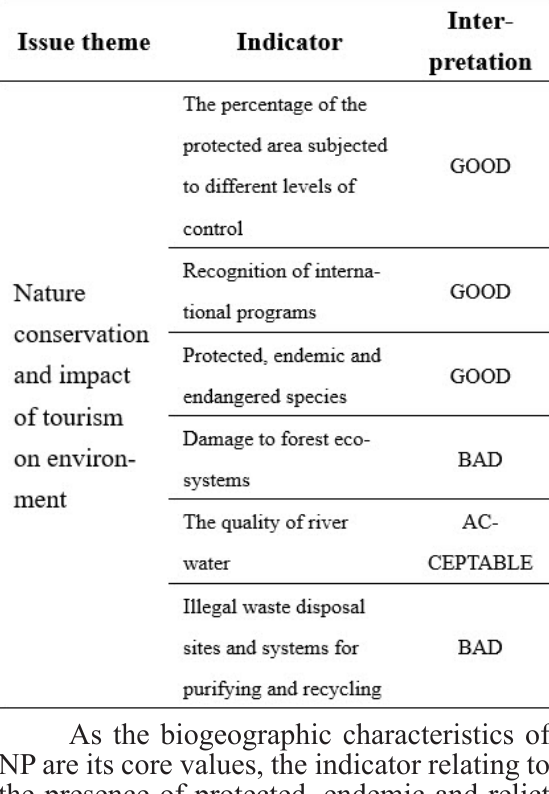
Table 2. Interpretation of indicators